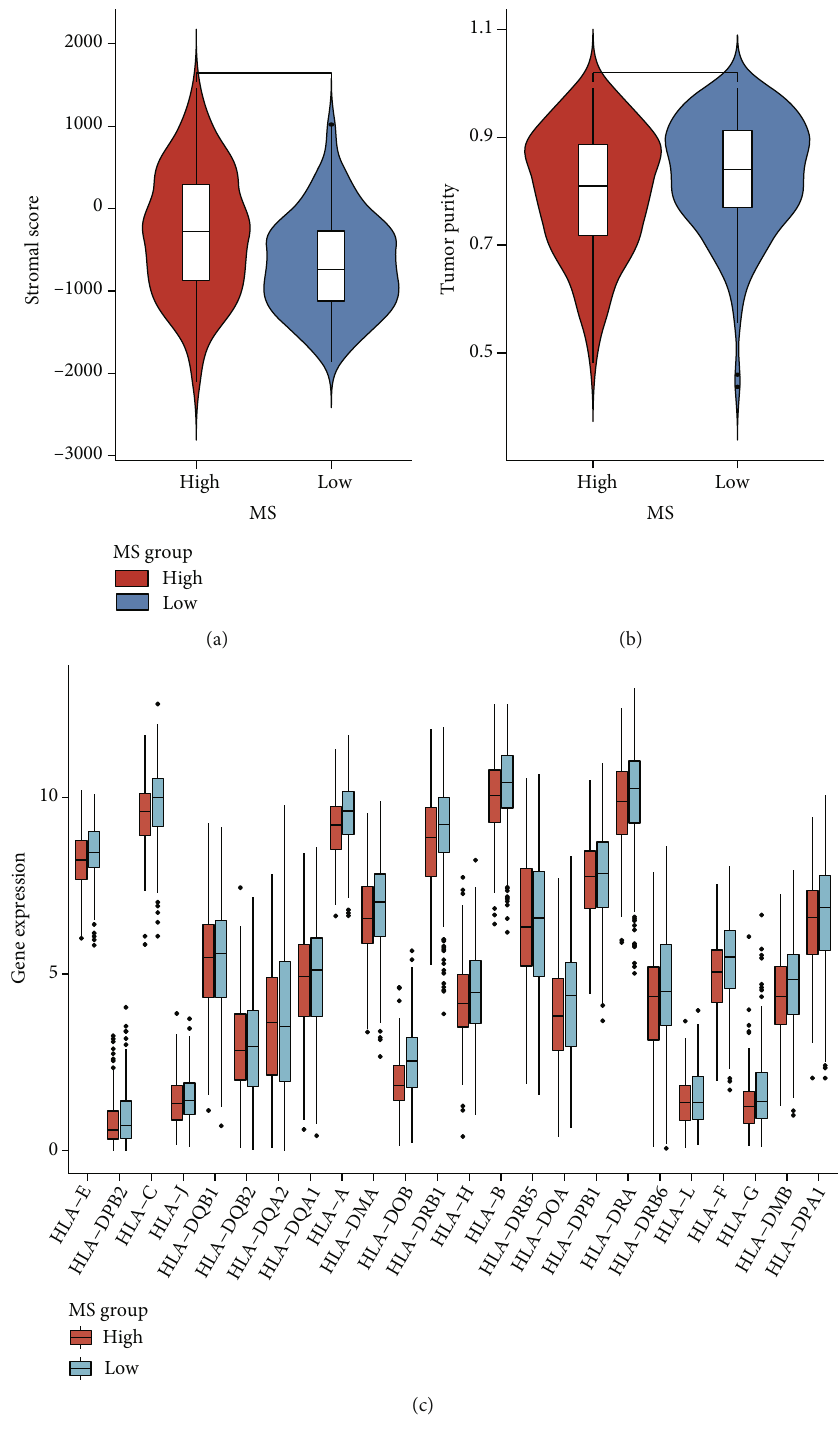
Figure 6: Environment in fi ltration di ff erences between MS groups. (a) Di ff erential of stromal score in the MS groups. (b) Di ff erential of tumor purity in the MS groups. (c) Human leukocyte antigen (HLA) expressions in di ff erent MS